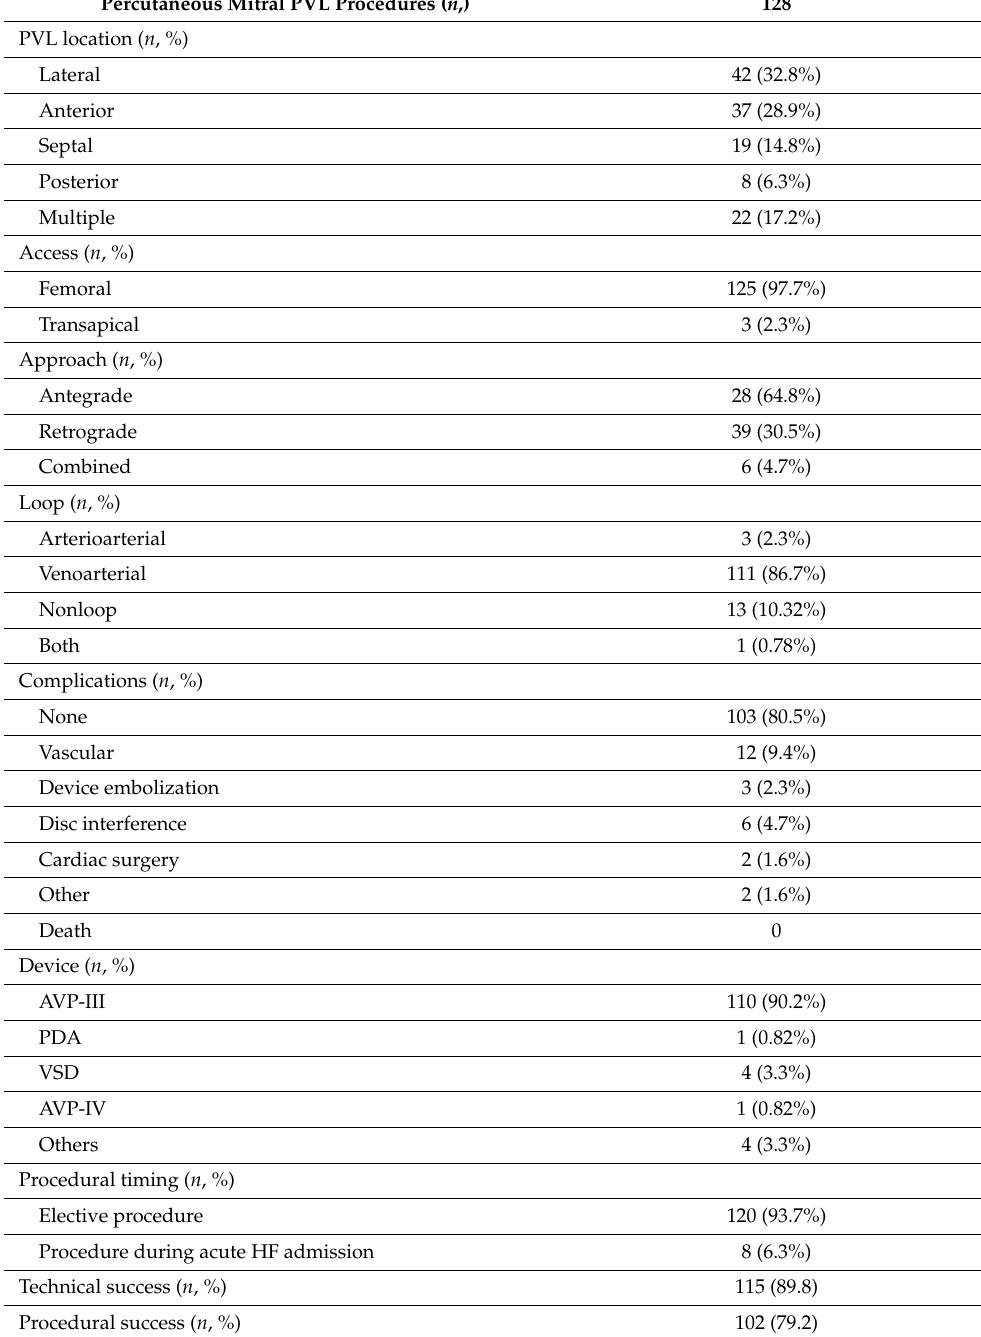
Table 2. Procedural